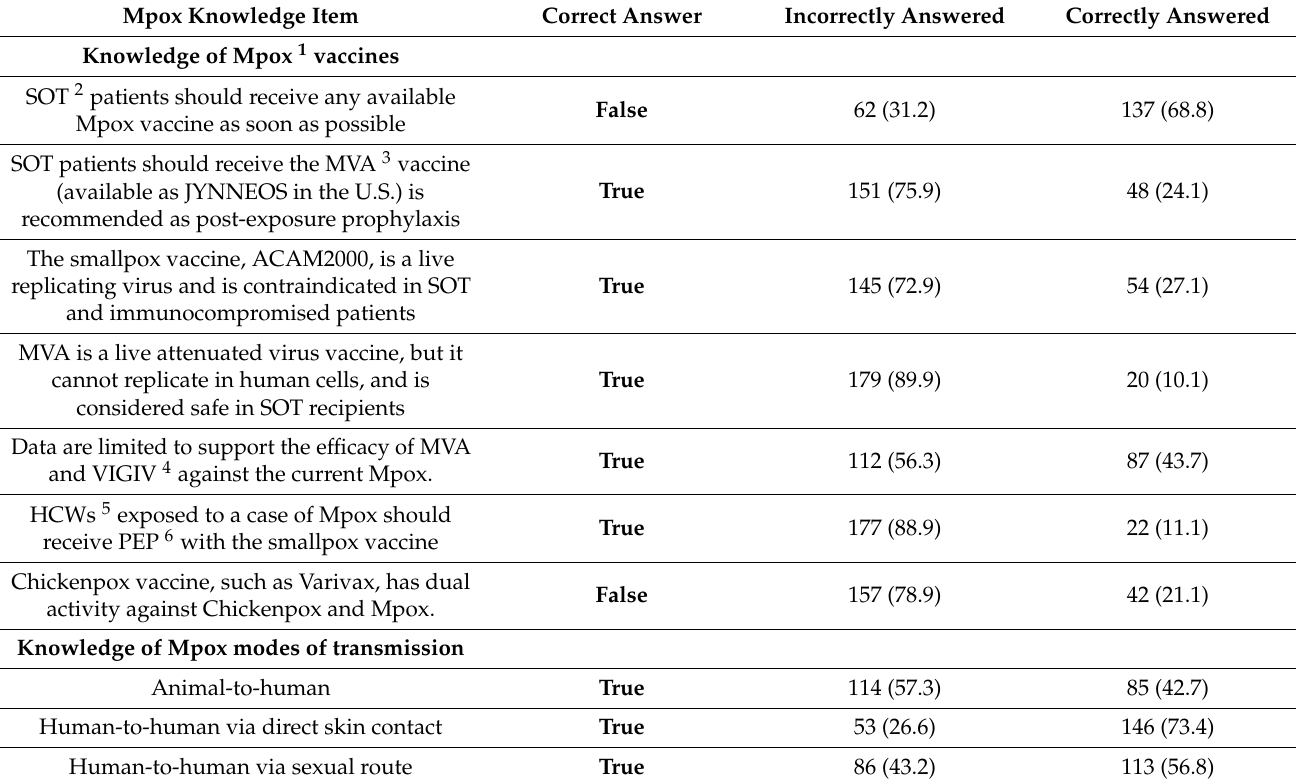
Table A1. Descriptive analysis of the healthcare workers knowledge about various Mpox disease